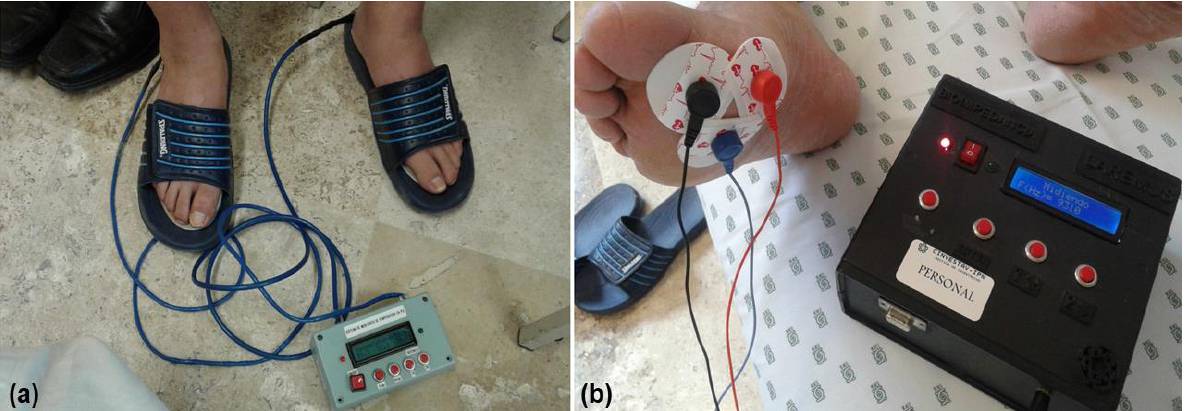
Figure 1. ( a ) Electronic system and templates with integrated sensors for temperature measurement [17]. ( b ) Electrical impedance measurement system with three electrodes performing an impedance measurement